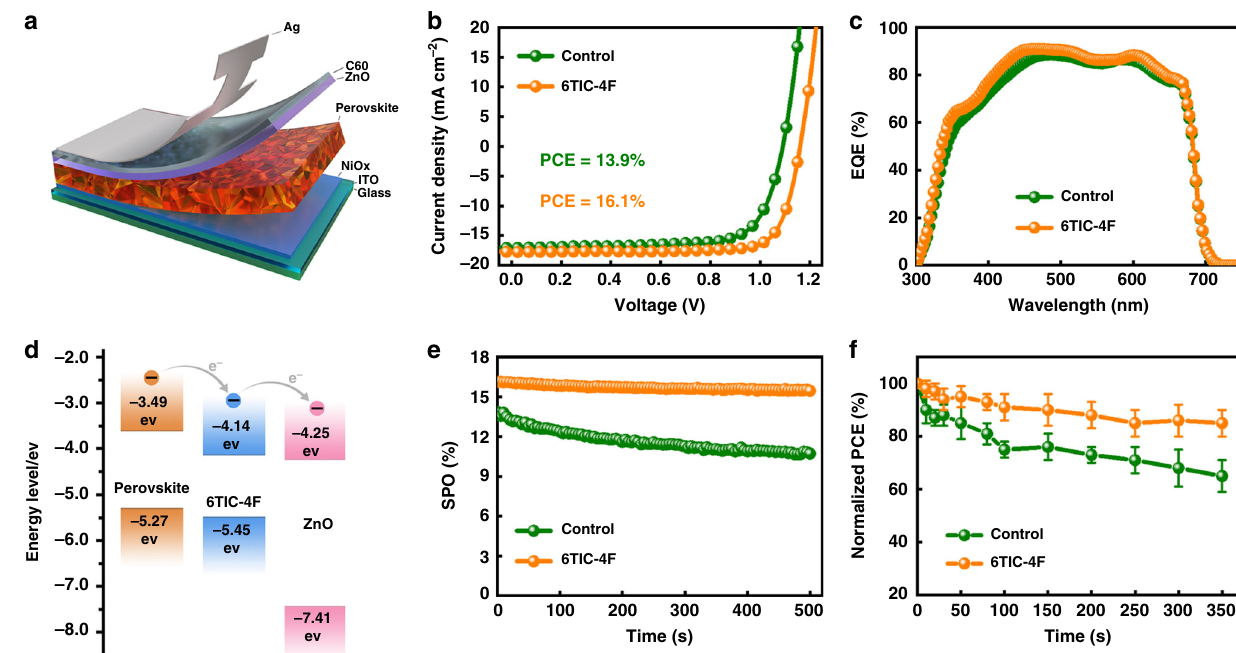
Fig. 2 Device performance. a Device architecture and d the energy-level diagram of the studied inverted CsPbI x Br 3 − x PVSC. b The J – V curves and c the EQE spectra of the champion CsPbI x Br 3 − x PVSCs without (green) and with (orange) 6TIC-4F passivation. e Stabilized power output tests and f normalized ef fi ciencies of the studied CsPbI x Br 3 − x PVSCs under continuous one sun equivalent illumination. The error bars represents the standard deviations for PCE of the devices.